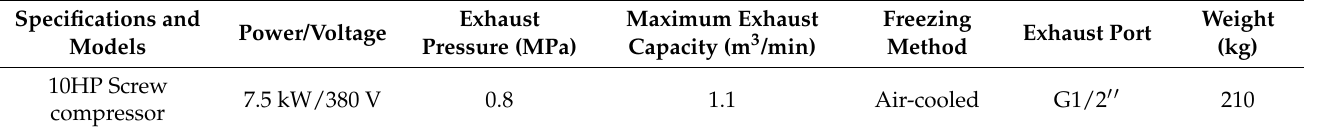
Table 1. Compressor